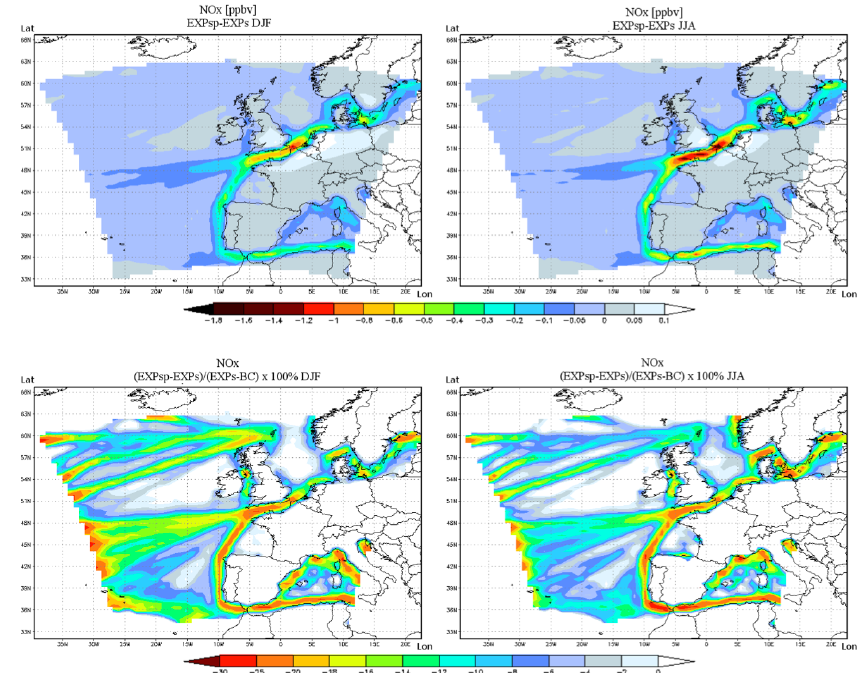
Fig. 23. Change in NO x production by ship emissions. Top panels: difference of surface NO x in experiments with and without plume model, ε NO (Eq. 56) inppbv for winter (left) and summer conditions (right). Bottom panels: same but for relative change ε NO x et al.,